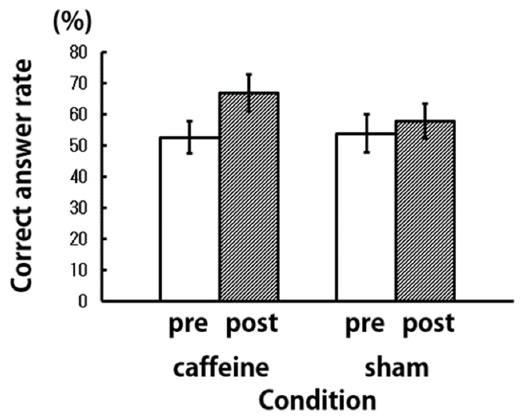
Figure 5. Percentage of correct answer in the letter 3-back working memory task ( N = 9).